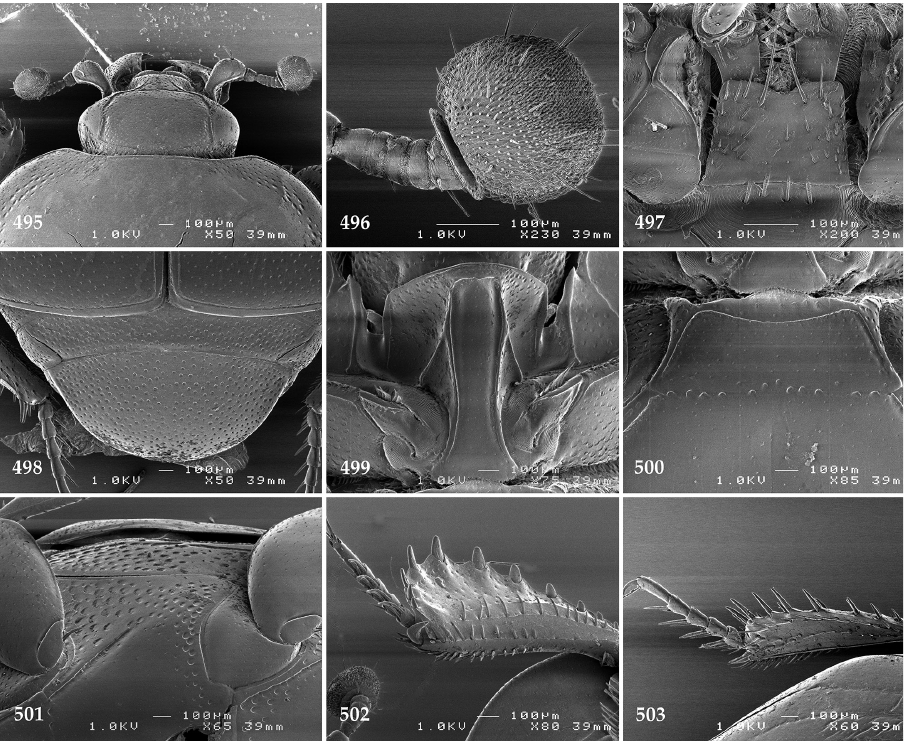
Figures 495–503. 495 Saprinus ( Saprinus ) pacificus sp. n. head, dorsal view 496 antennal club, dorsal view 497 mentum, ventral view 498 propygidium + pygidium 499 prosternum 500 mes- oventrite 501 lateral disc of metaventrite + metepisternum 502 protibia, ventral view 503 mesotibia, dorsal